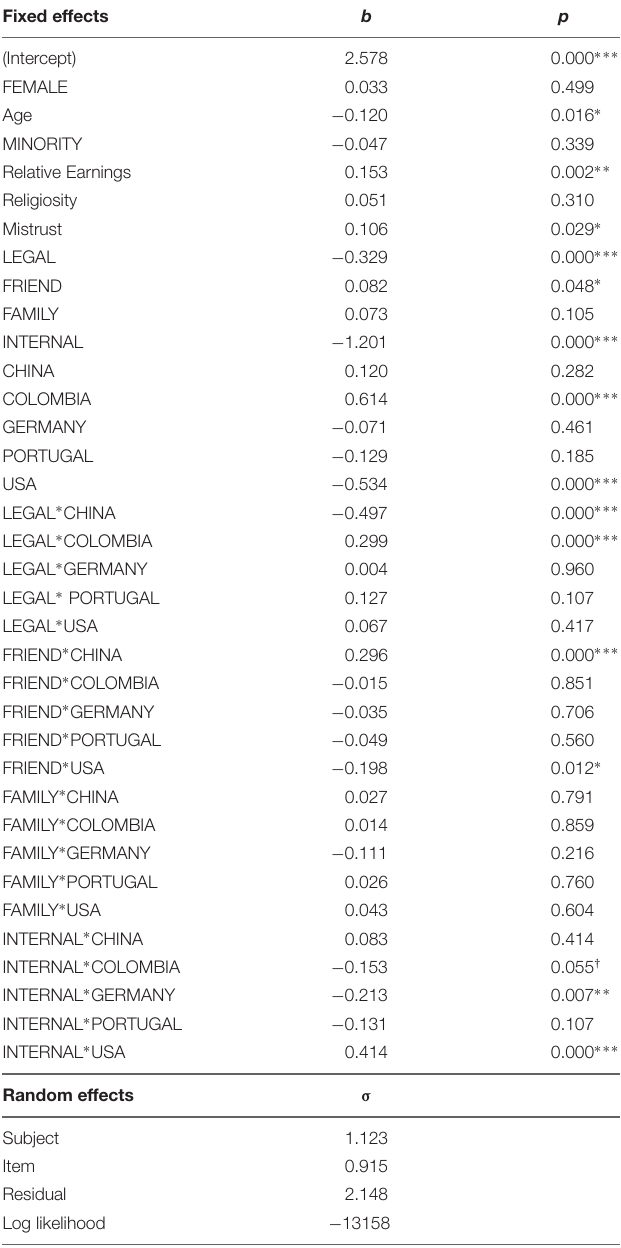
TABLE 5 | Results from a linear mixed effects model (ML estimation) for likelihood of engaging in crime, with demographics, sanction variables, and countries included as fixed effect